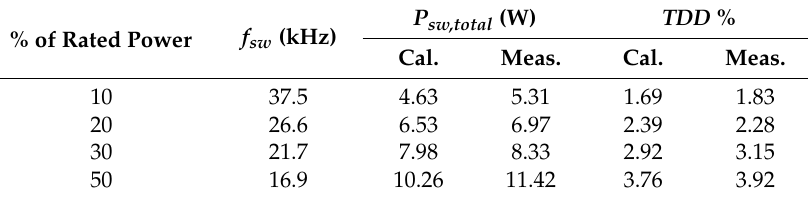
Table 4. Comparison between the experimental and calculated